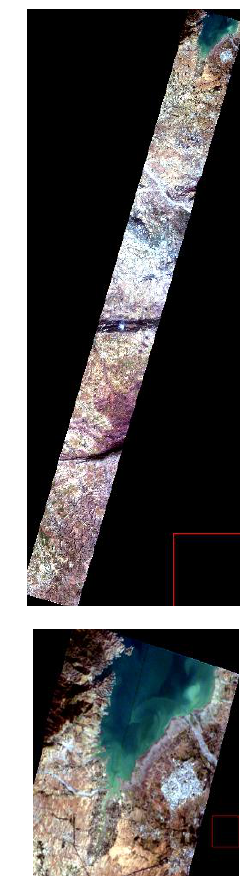
Figure 8. The Acquired Hyperion Orthoimage (top image) and Subset of Acquired Hyperion Orthoimage (bottom image) covering the studied